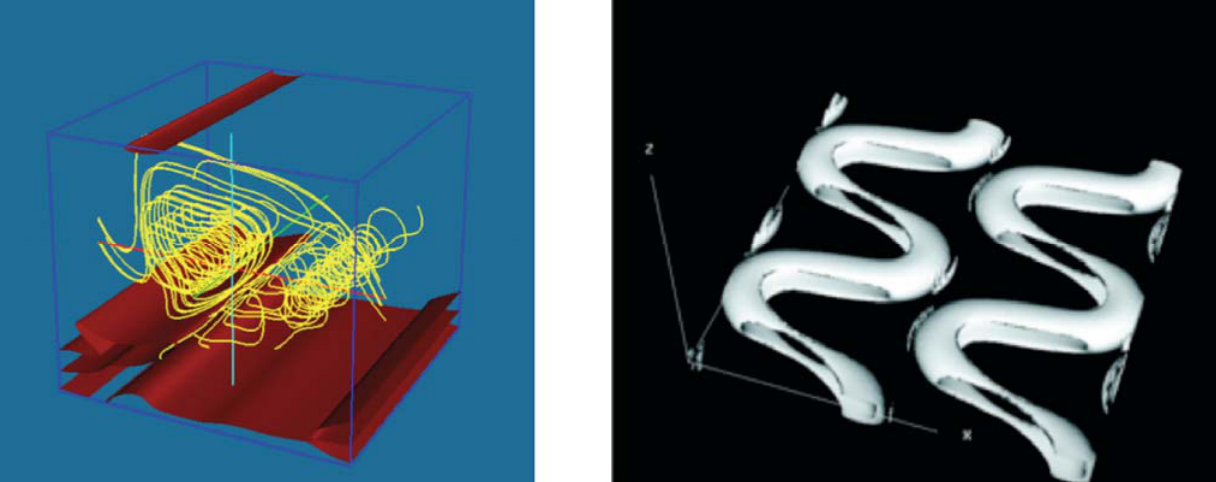
Figure 22. Left: MHDCHAN 3D MHD simulation of the UT-Austin Helimak evolution. Vorticity isosurfaces and some streamlines are shown. Right: MHDFSL 3D simulation of the secondary instability that may provide explanation for the fast observed solar magnetic reconnection timescales. A late stage plasma current configuration is